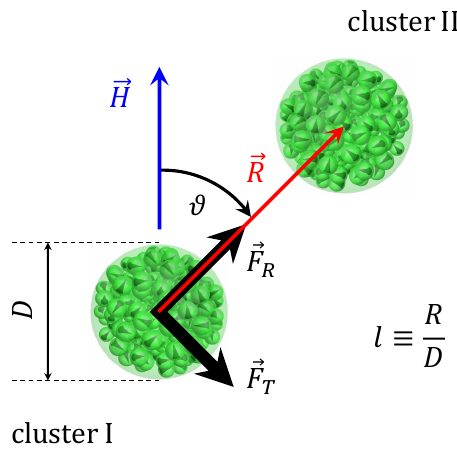
Figure 1. Schematic representation of the